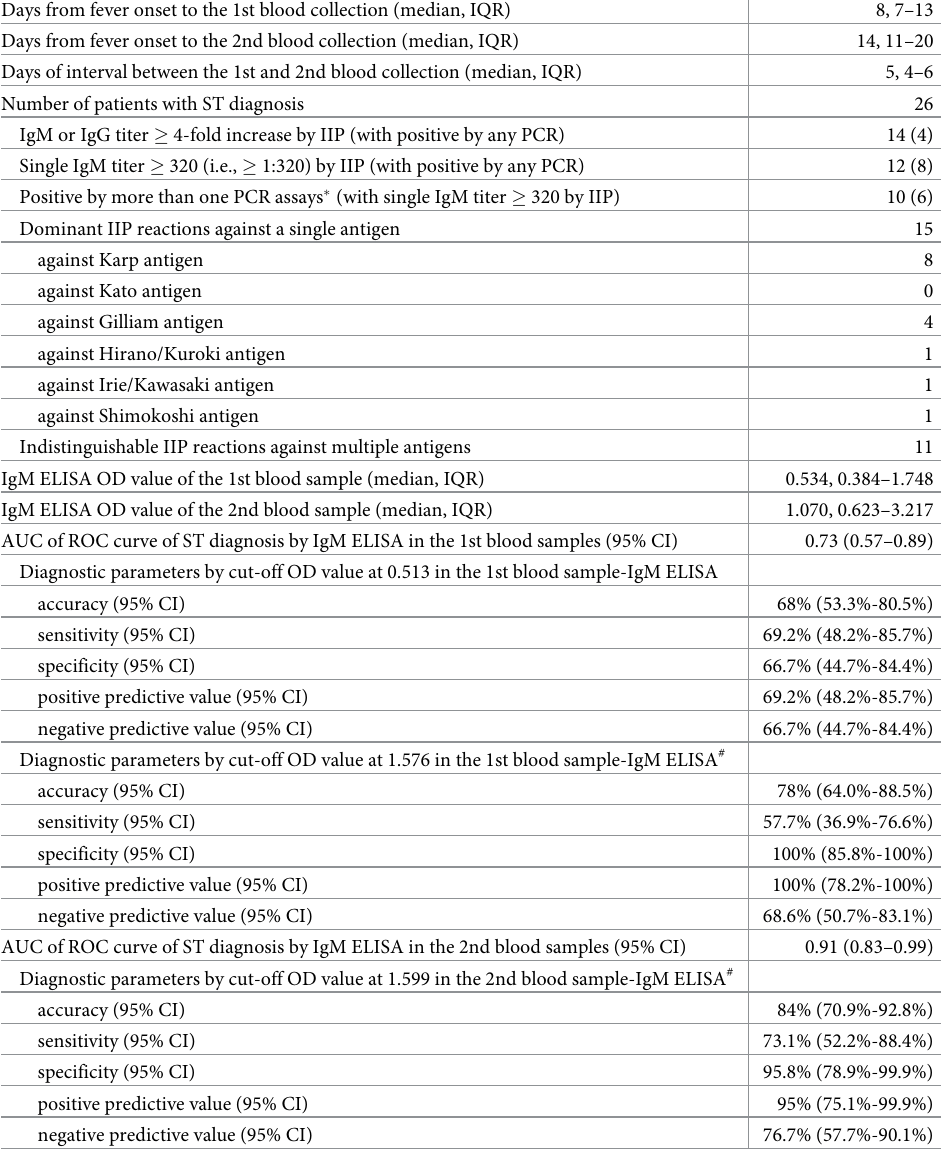
Table 3. Summary of diagnostic test results in the 50 patients screened positive by the second blood-IgM ELISA. Days from fever onset to the 1st blood collection (median, IQR) 8, 7–13 Days from fever onset to the 2nd blood collection (median, IQR) 14, 11–20 Days of interval between the 1st and 2nd blood collection (median, IQR) 5, 4–6 Number of patients with ST diagnosis 26 IgM or IgG titer � 4-fold increase by IIP (with positive by any PCR) 14 (4) Single IgM titer � 320 (i.e., � 1:320) by IIP (with positive by any PCR) 12 (8) Positive by more than one PCR assays � (with single IgM titer � 320 by IIP) 10 (6) Dominant IIP reactions against a single antigen 15 against Karp antigen 8 against Kato antigen 0 against Gilliam antigen 4 against Hirano/Kuroki antigen 1 against Irie/Kawasaki antigen 1 against Shimokoshi antigen 1 Indistinguishable IIP reactions against multiple antigens 11 IgM ELISA OD value of the 1st blood sample (median, IQR) 0.534, 0.384–1.748 IgM ELISA OD value of the 2nd blood sample (median, IQR) 1.070, 0.623–3.217 AUC of ROC curve of ST diagnosis by IgM ELISA in the 1st blood samples (95% CI) 0.73 (0.57–0.89) Diagnostic parameters by cut-off OD value at 0.513 in the 1st blood sample-IgM ELISA accuracy (95% CI) 68% (53.3%-80.5%) sensitivity (95% CI) 69.2% (48.2%-85.7%) specificity (95% CI) 66.7% (44.7%-84.4%) positive predictive value (95% CI) 69.2% (48.2%-85.7%) negative predictive value (95% CI) 66.7% (44.7%-84.4%) accuracy (95% CI) sensitivity (95% CI) specificity (95% CI) positive predictive value (95% CI) negative predictive value (95% CI) 68.6% (50.7%-83.1%) AUC of ROC curve of ST diagnosis by IgM ELISA in the 2nd blood samples (95% CI) 0.91 (0.83–0.99) accuracy (95% CI) sensitivity (95% CI) specificity (95% CI) 95.8% (78.9%-99.9%) positive predictive value (95% CI) 95% (75.1%-99.9%) negative predictive value (95% CI) 76.7%